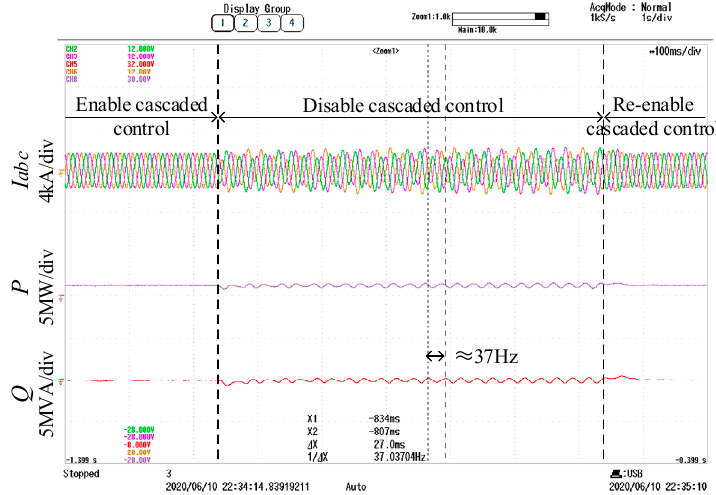
Figure 14. Waveforms of disable and re-enable the cascaded inner control loop in VSG control strategy with series-compensated grid.